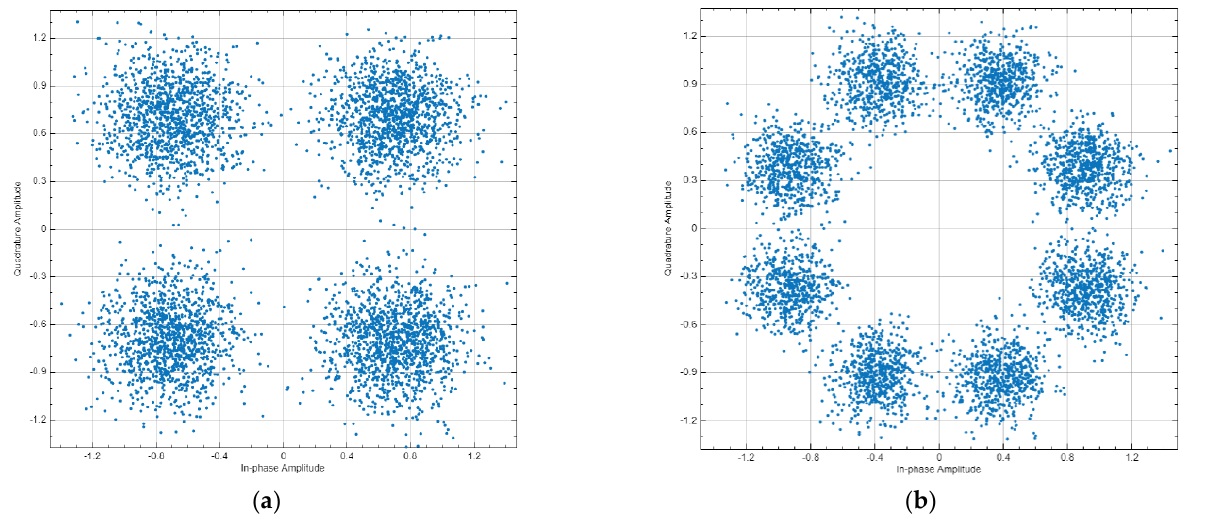
Figure 18. Constellation diagrams of satellite demodulators ( a ) QPSK modulation; ( b ) 8PSK modu-